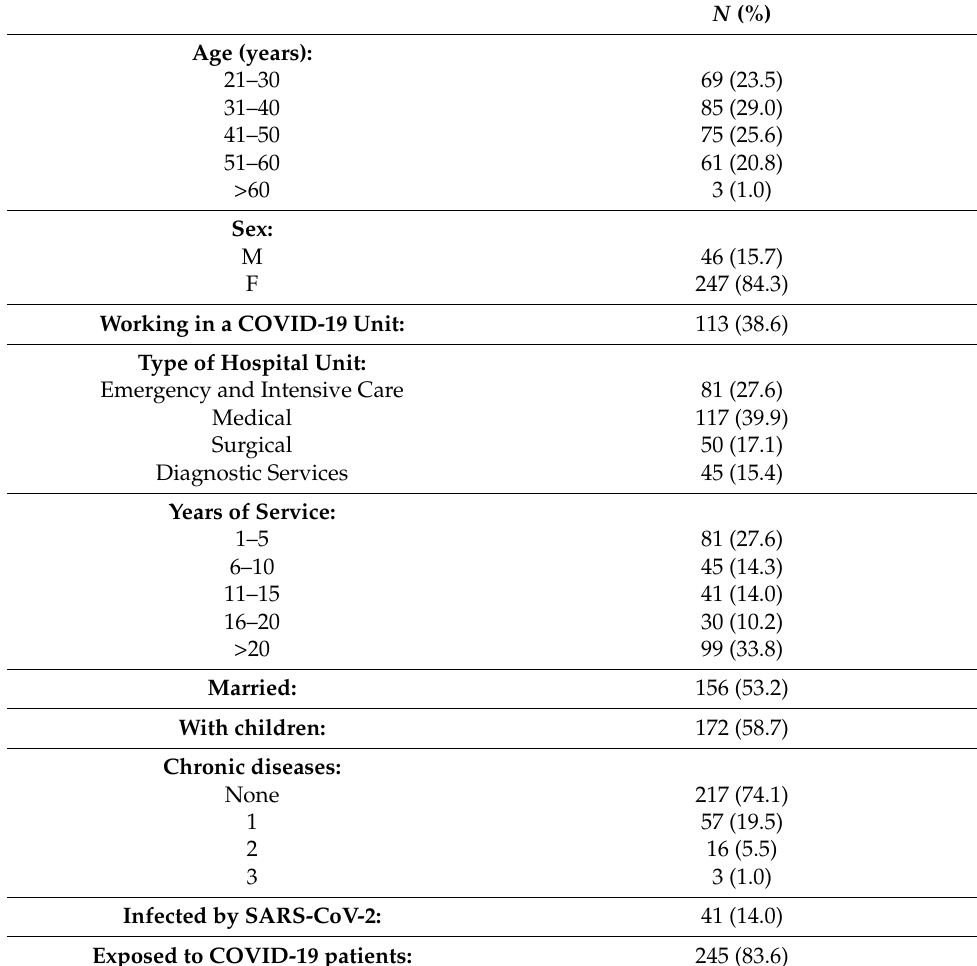
Table 1. Demographic and occupational characteristics of the studied